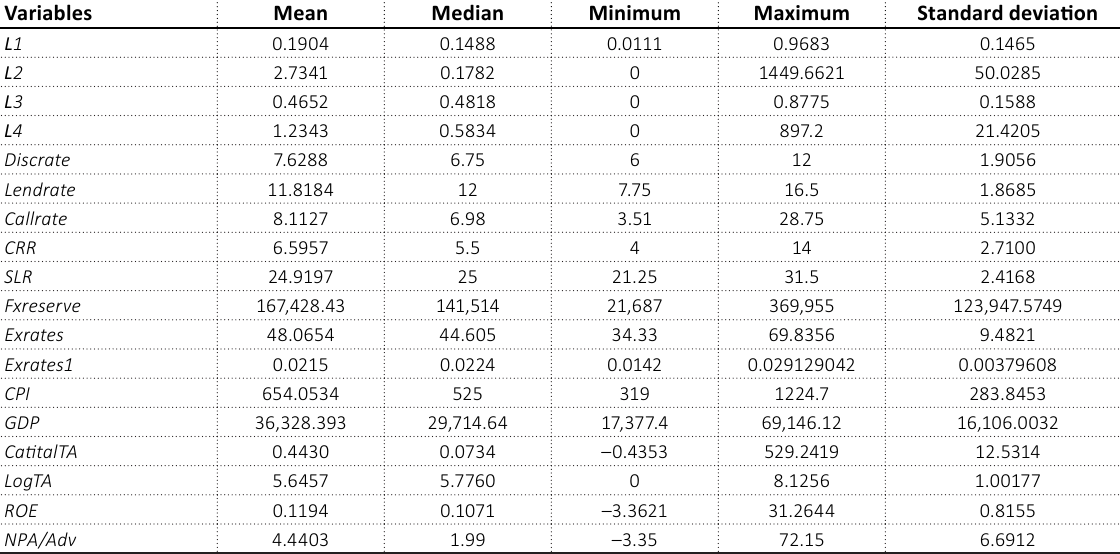
Table 2. Descriptive statistics of variables